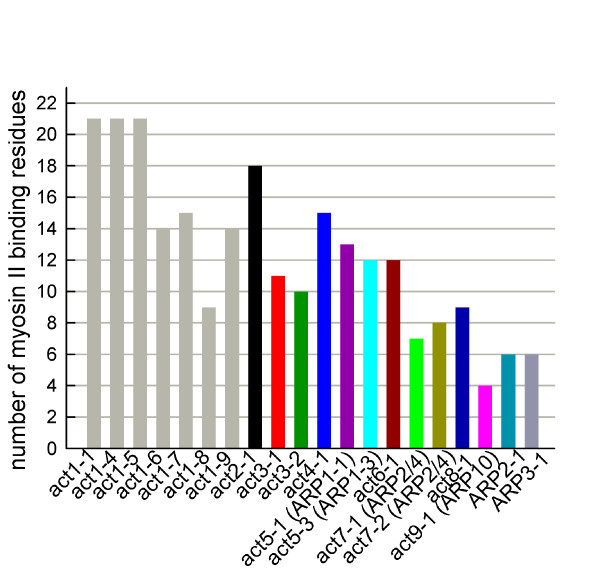
Conservation pattern of myosin II- binding residues.Conservation pattern of 23 myosin II-binding residues (2, 24, 25, 40, 42, 144–148, and 341–353). For subfamilies in which the conservation pattern is identical for all members, only one is shown.